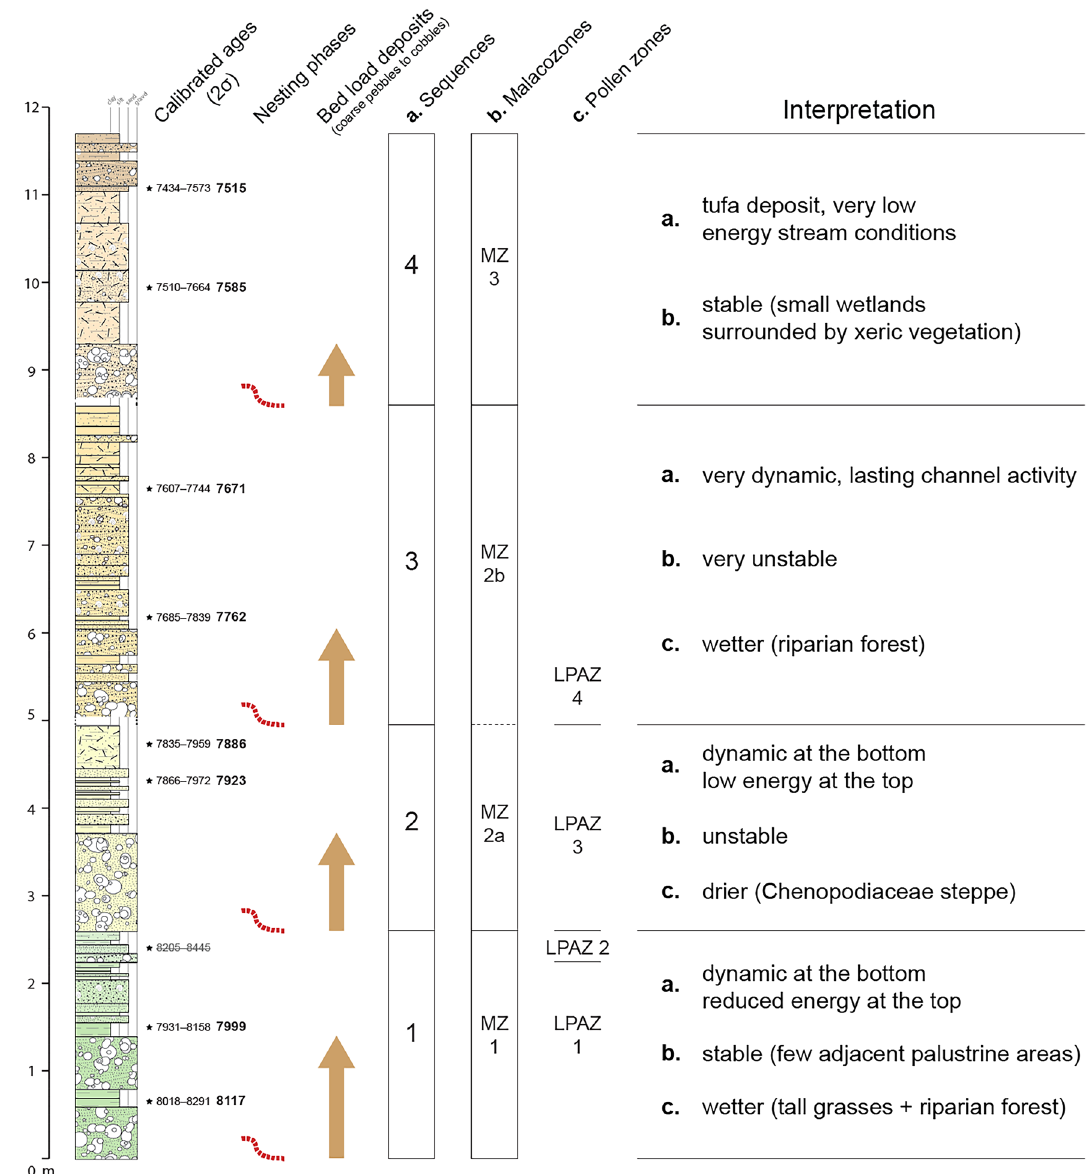
Figure 4. Synthetic results from the stratigraphic, sedimentological, malacological, and pollen analyses of the Cha07 palaeochannel